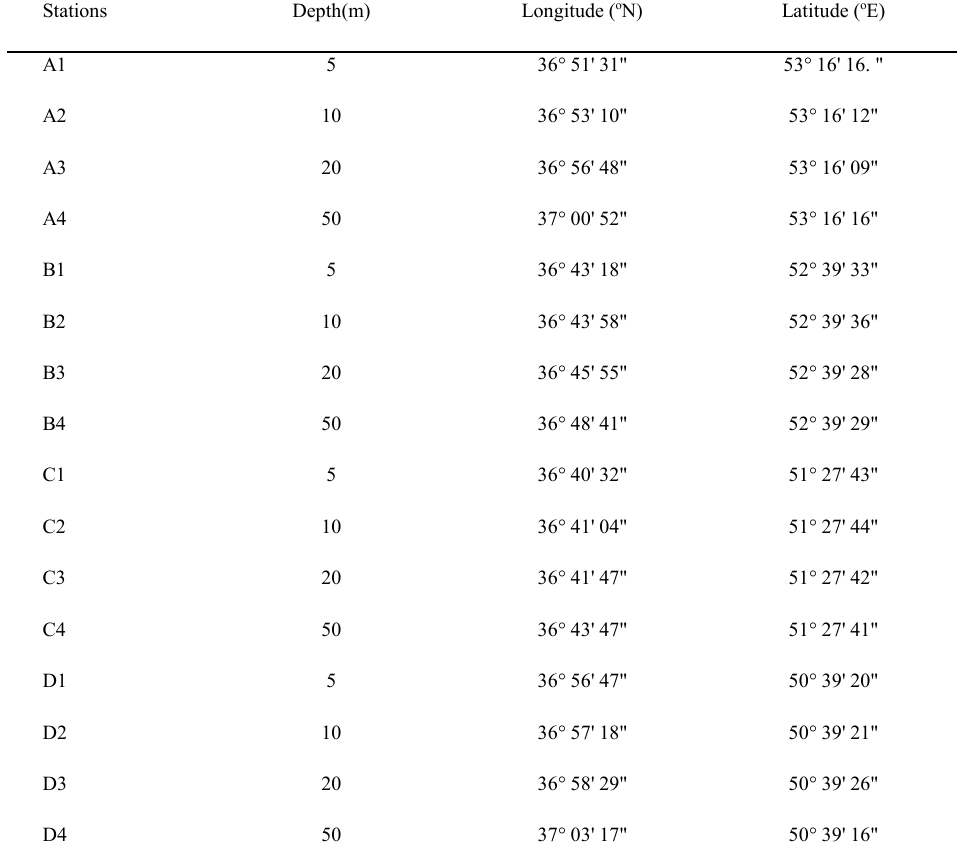
Table 1: Position of sampling